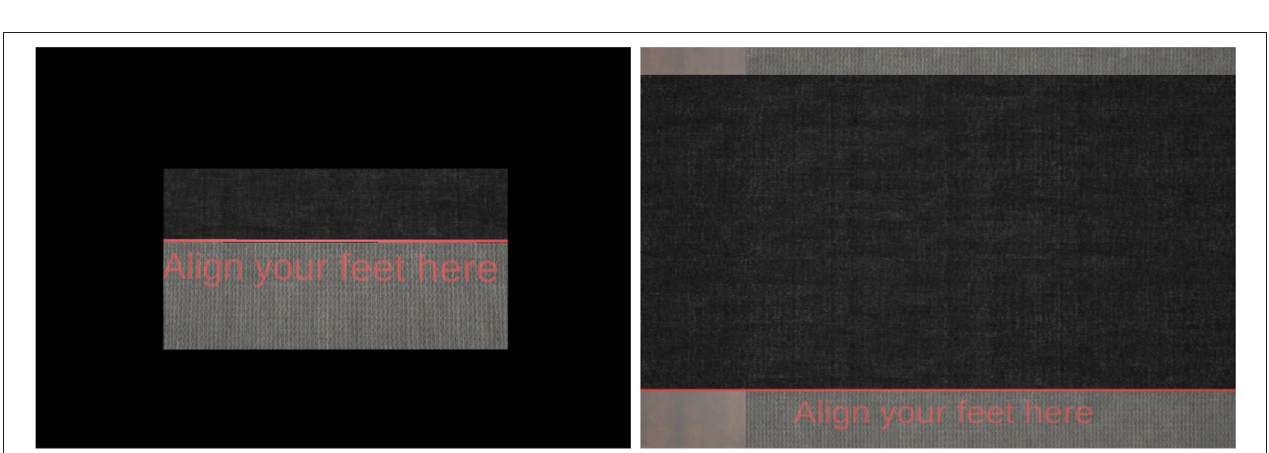
FIGURE 6 | The virtual environment used in Experiment 3. Participants aligned their feet to the red line without visual self-representation.